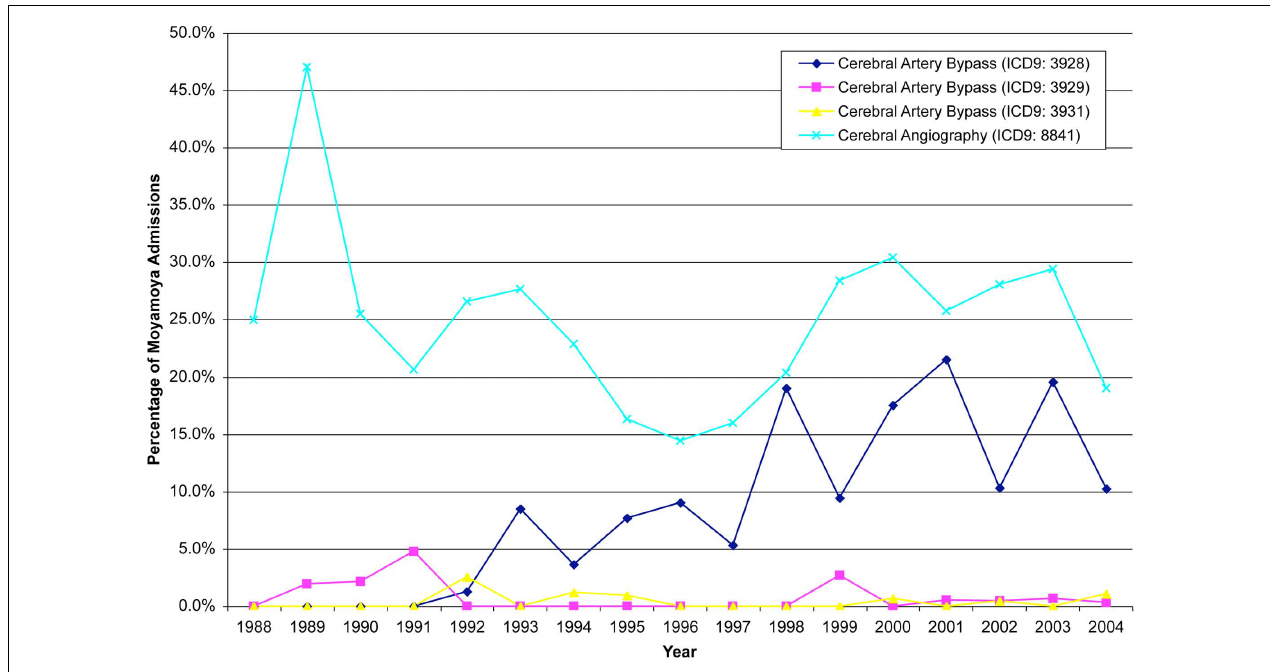
FIGURE 3 |Angiography remains the most common procedure associated with patients admitted for moyamoya, while there has been progressively more cerebral artery bypasses from